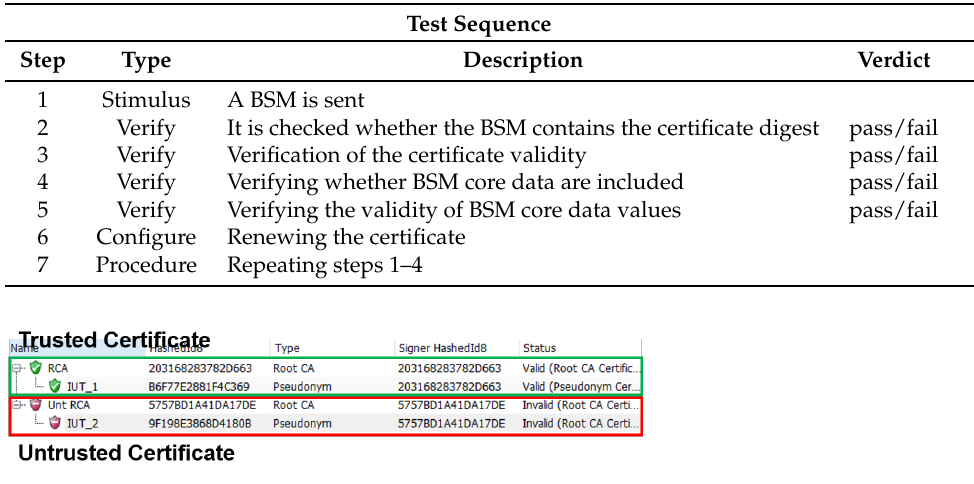
Figure 13. Certificates that can be used when the evaluation target node sends a BSM. The evaluation target node sends a BSM using the specified certificate. Two types of certificates (a trusted and untrusted certificate) were generated to show the pass and fail scenarios.